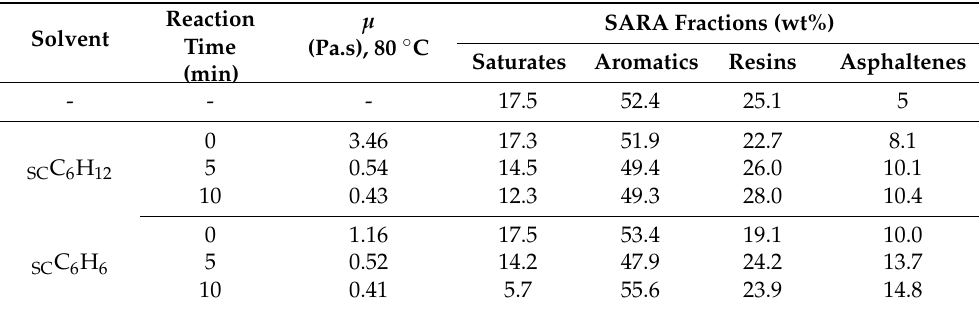
Table 3. Dynamic viscosity and SARA distribution of visbreaking products obtained in SC C 6 H 6 and SC C 6 H 12 . Temperature of 380 ◦ C, solvent-to-heavy-oil ratio of 3:1 (wt), and solvent density of 0.25